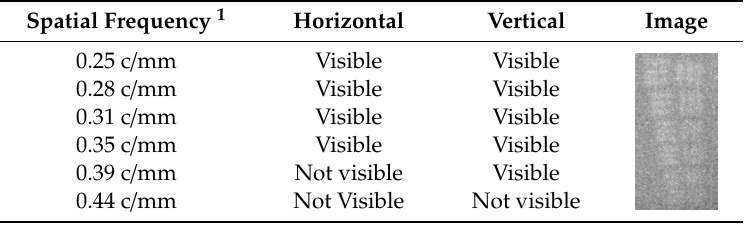
Table 1. Visibility of the resolution standard’s tri-bar patterns.